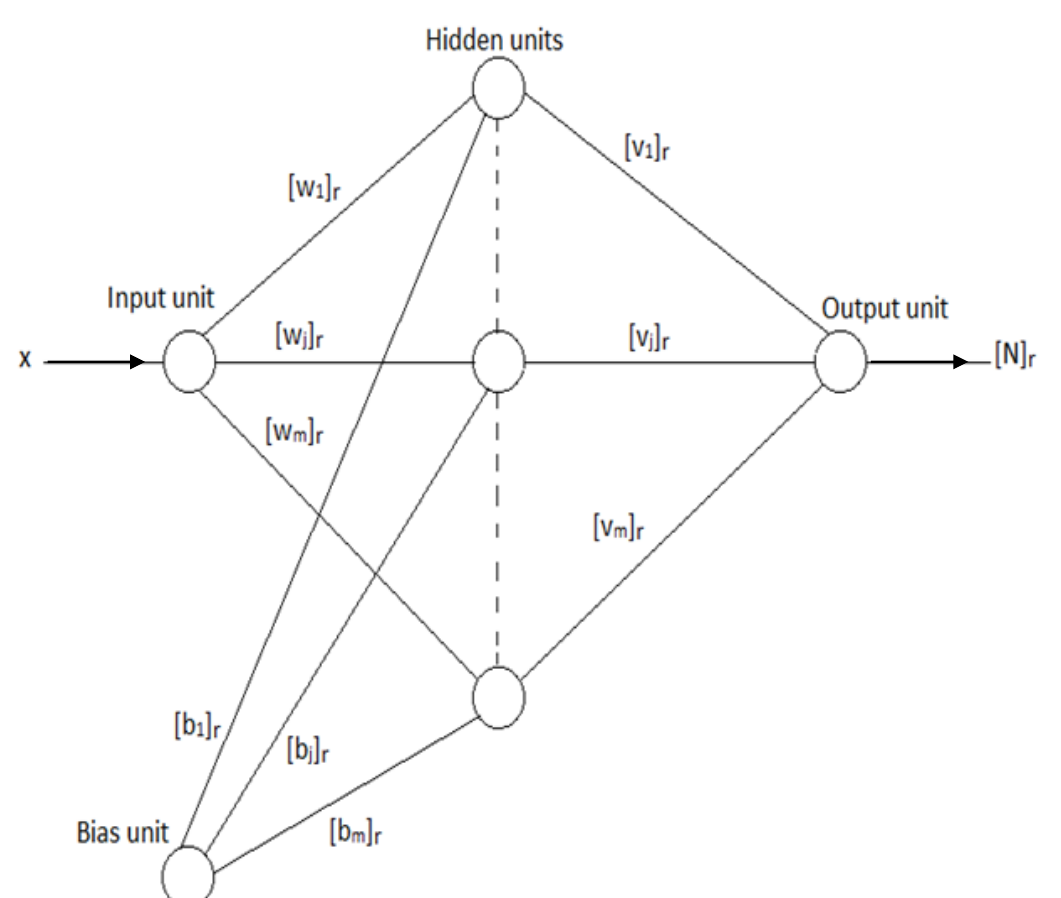
Figure1: ( 1 × m × 1 ) Fully fuzzy feed-forward neural